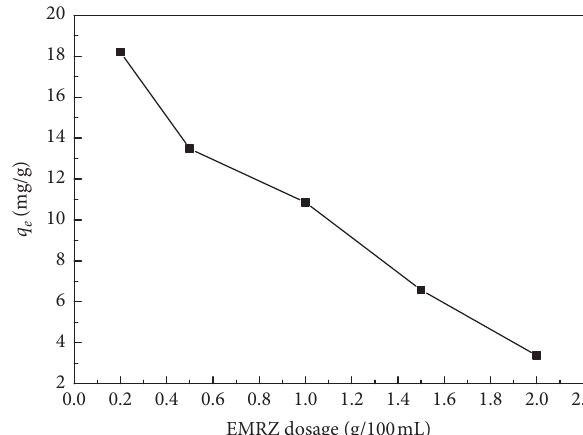
Figure 5: Effect of EMRZ dosage on ammonium adsorption (initial ammonium concentration � 100mg/L; temperature � 25 ° C; contact time � 100min; pH value � 8.0).